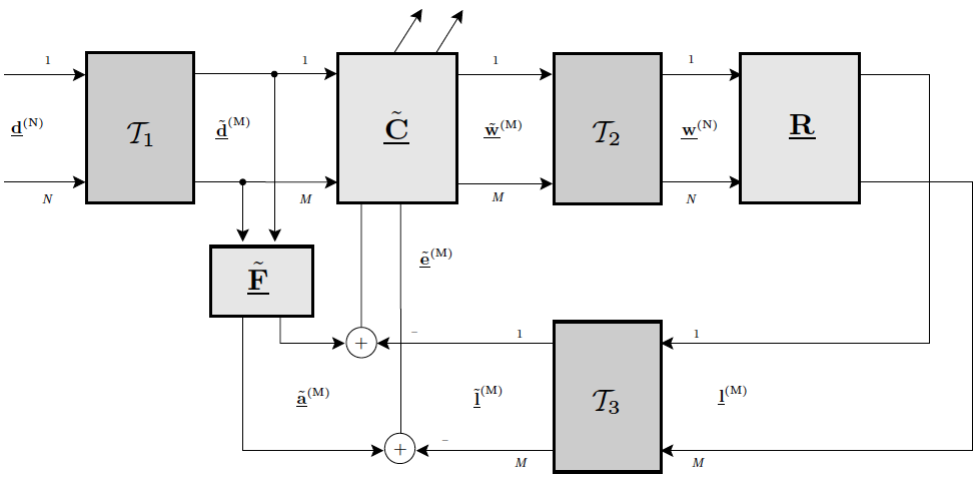
Figure 10. Block diagram illustrating the concept of wave domain adaptive filtering (WDAF)-based room equalization. The driving signals for the N loudspeakers—denoted by d ( N ) —are transformed into the wave domain using the spatio-temporal transform T 1 , resulting in M transformed components ˜ d ( M ) . These are filtered in the wave domain by the MIMO matrix ˜ C of equalization filters, resulting in the pre-filtered loudspeaker driving signals ˜ w ( M ) , which are then transformed back by T 2 . The acoustic paths between the N loudspeakers and M control points (microphones) are combined into the MIMO room transfer matrix R . The signals at the control points l ( M ) are transformed into the wave domain ( M ) using transformation T 3 , resulting in the transformed control signals ˜ l . The desired free-field propagation is modeled in the wave domain by the MIMO matrix ˜ F of free-field transfer functions, resulting in the transformed desired signals ˜ a ( M ) at the control points. The error ˜ e ( M ) used for adaptation of the compensation filters is given by the difference of the transformed desired signals ( M ) ˜ a ( M ) and the actual signals ˜ l at the control